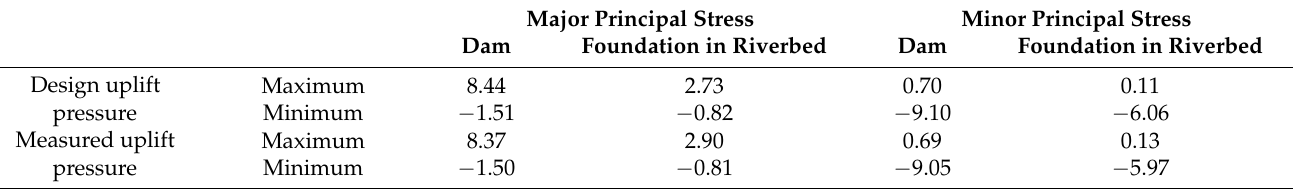
Table 3. Stress under design and measured uplift pressure (Unit: MPa).